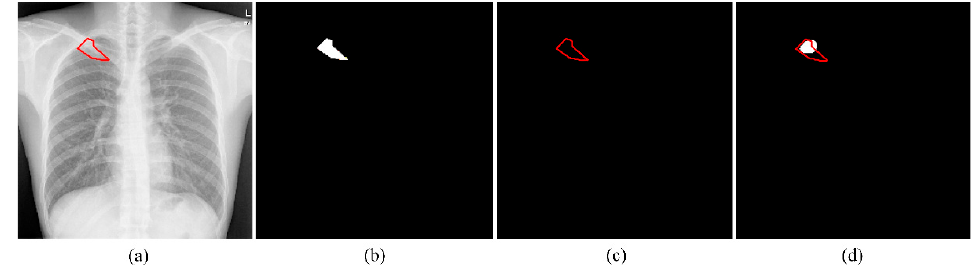
Figure 6. TB-consistent lesion segmentation performance using the U-Net with Inception-V3 encoder backbone and the stacking ensemble of the top-3 performing models. ( a ) Sample original CXR image with TB-consistent lesion annotated in red; ( b ) GT TB-consistent lesion mask; ( c ) Predicted mask using the Inception-V3 encoder backbone with overlapping GT annotations in red, and ( d ) Predicted mask using the stacking ensemble with overlapping GT annotations in red.